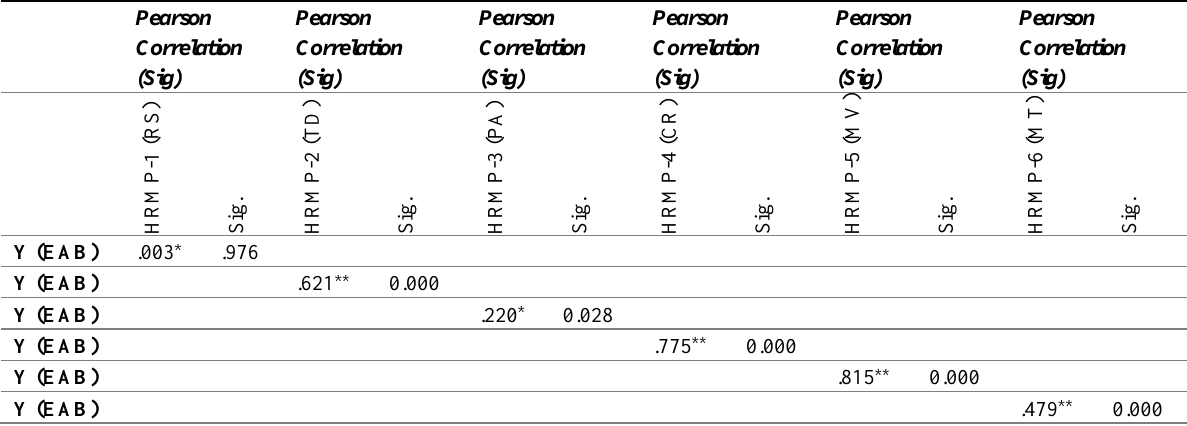
Pearson Correlation